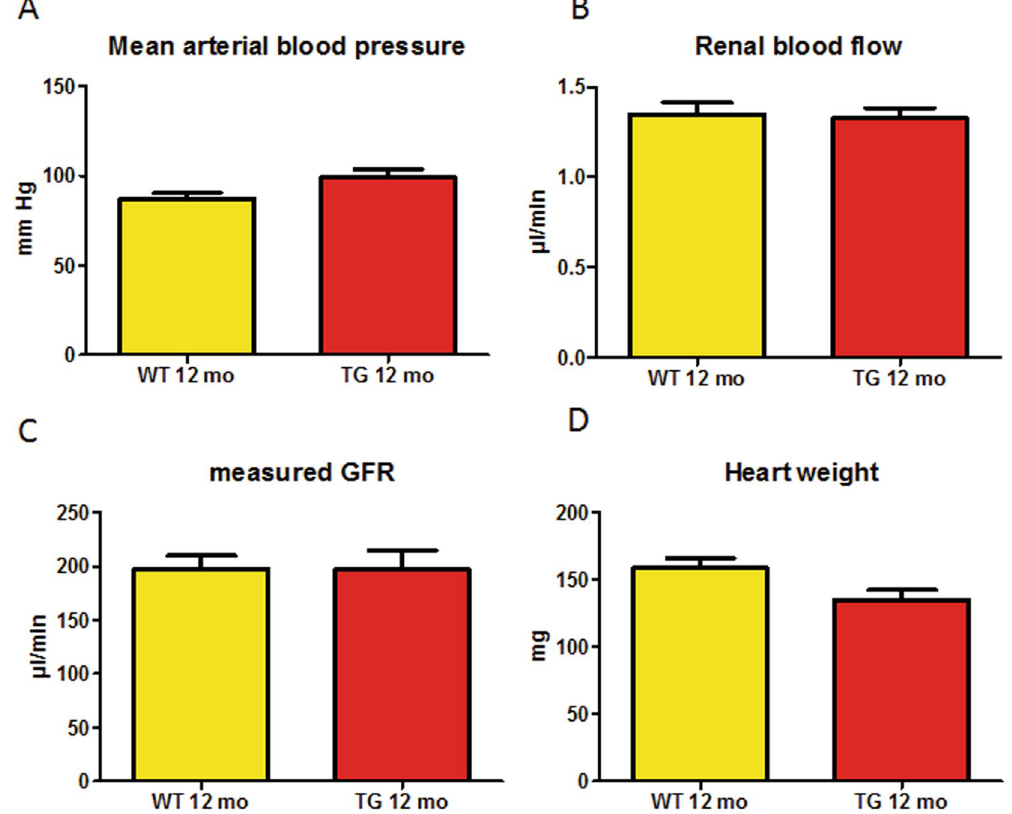
Figure 5. Calpastatin overexpression does not impact hemodynamic or renal blood flow. At one year, blood pressure, renal blood flow and glomerular filtration rate (GFR) were similar in CalpTG (TG) and WT mice, evidencing that calpastatin does not protect kidney through hemodynamic improvement ( A–C , n = 6–10/ group). Although hemodynamic features were similar, there was a trend toward lower heart mass in CalpTG (TG) mice at one year ( D , p = 0.05, n =